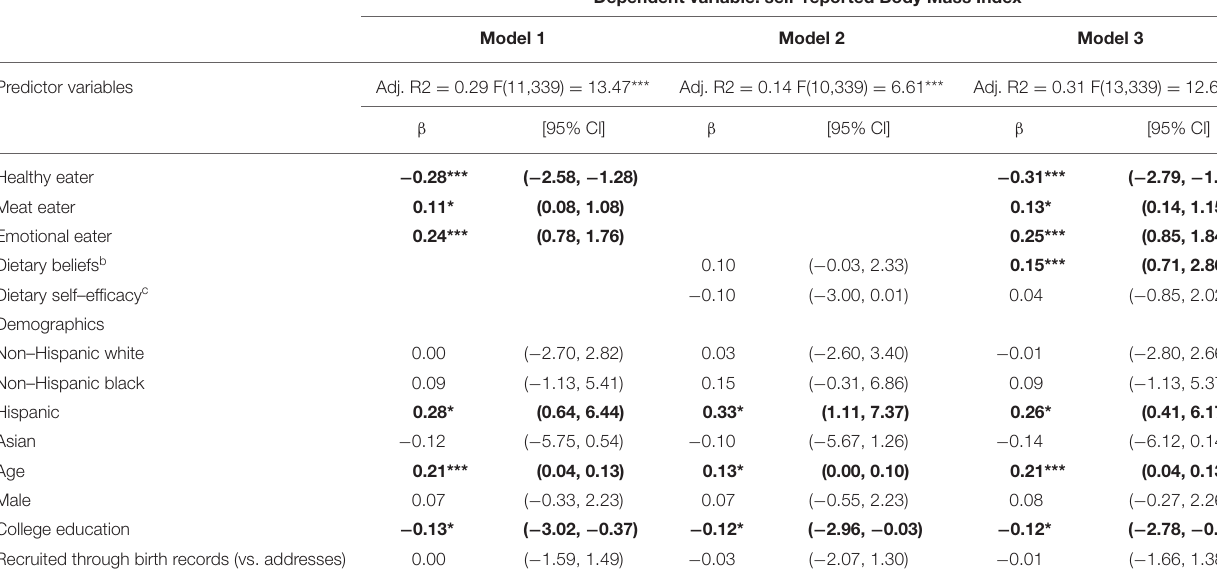
TABLE 8 | Linear regressions predicting Body Mass